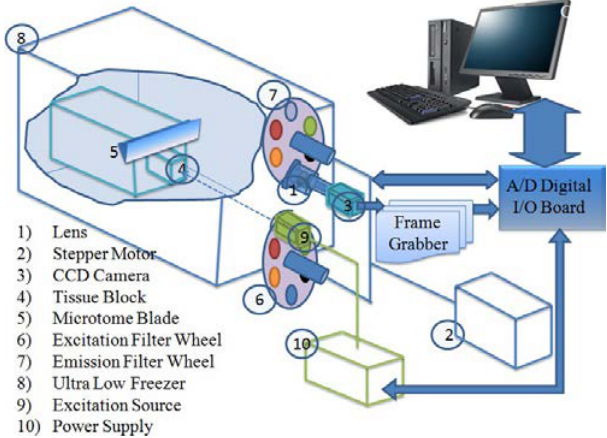
Fig. 1. Schematic of cryoimager.